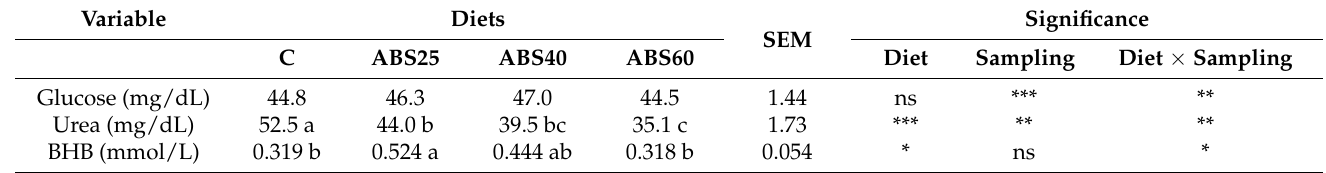
Table 6. Plasmatic profile according to the effects